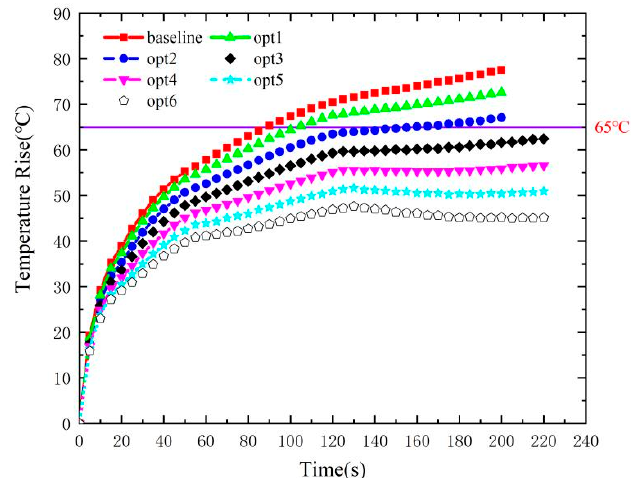
Figure 3. Variation in the highest temperature rise in the cylinder of the benchmark and precooling schemes.